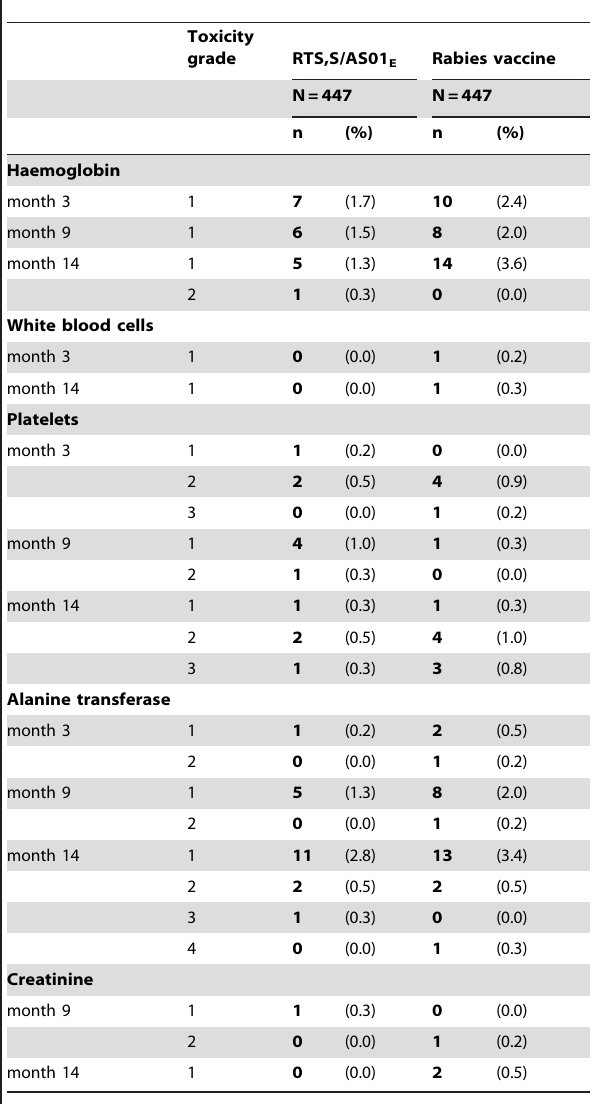
Table S1 Unsolicited events tables.